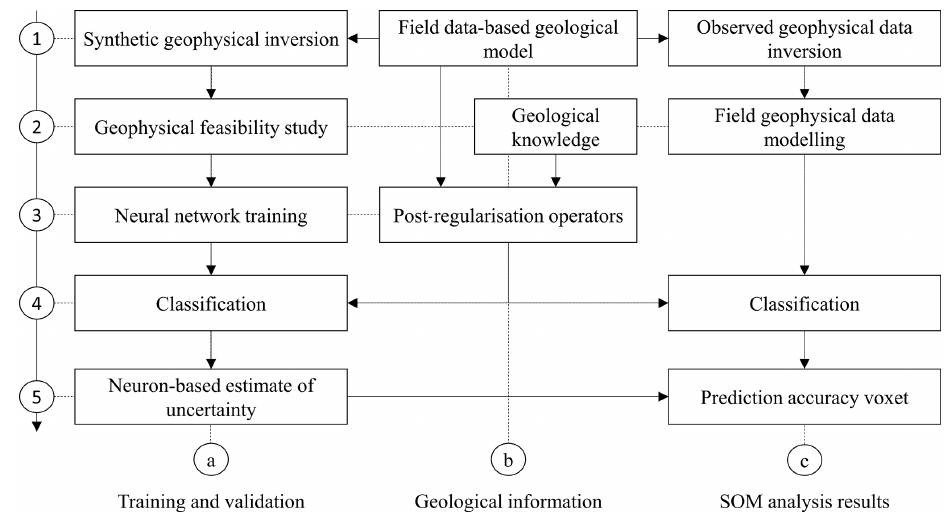
Figure 2. Schematic summary of proposed